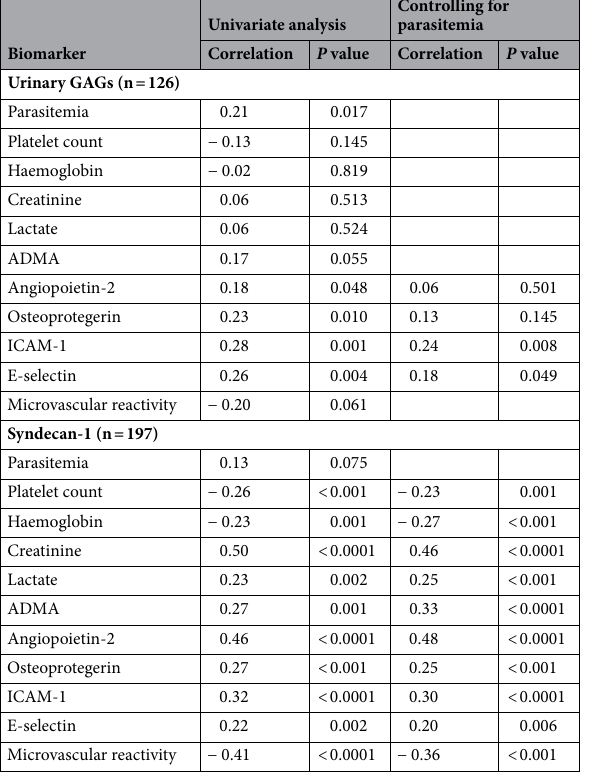
Table 2. Correlation coefficients between glycocalyx breakdown products and markers of severity in knowlesi malaria. After applying Bonferonni’s correction for the 11 variables evaluated in the correlation analyses above, correlations were considered statistically significant if p < 0.0045. GAGs glycosaminoglycans, ADMA asymmetric dimethylarginine, ICAM-1 intercellular adhesion